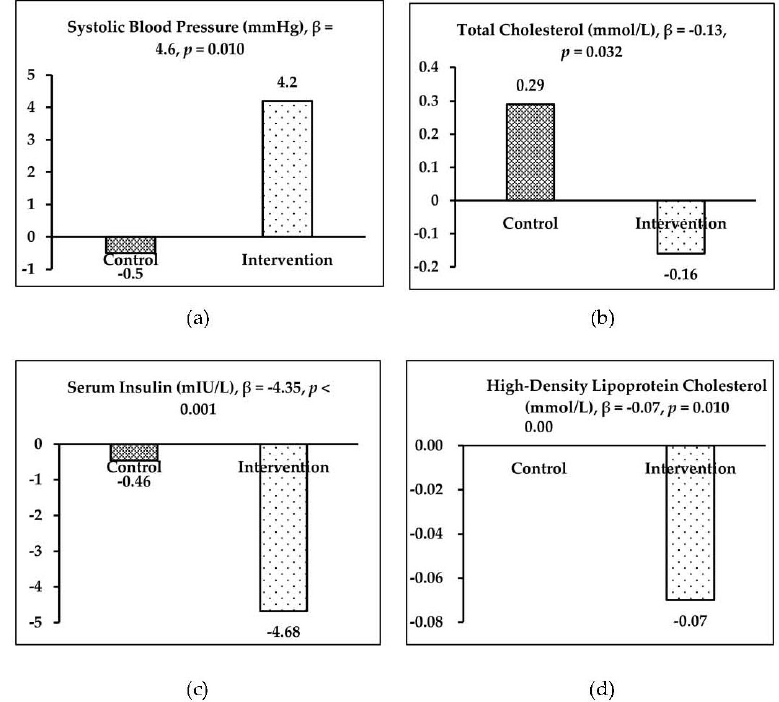
Figure 2. The significant intervention effects ( β ) in two groups: ( a ) SBP, ( b ) CHO, ( c ) INS and ( d ) HDL-